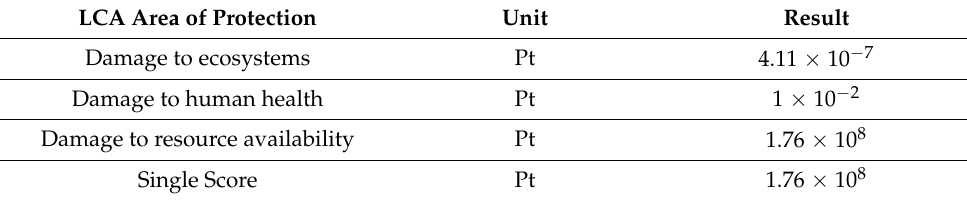
Table 6. Endpoint results, based on the FU.